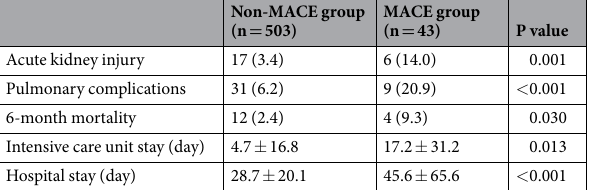
Table 4. Postoperative outcomes of 546 patients who underwent radical cystectomy. Data are expressed as mean ± standard deviation or number of patients (%). MACE = major adverse cardiac